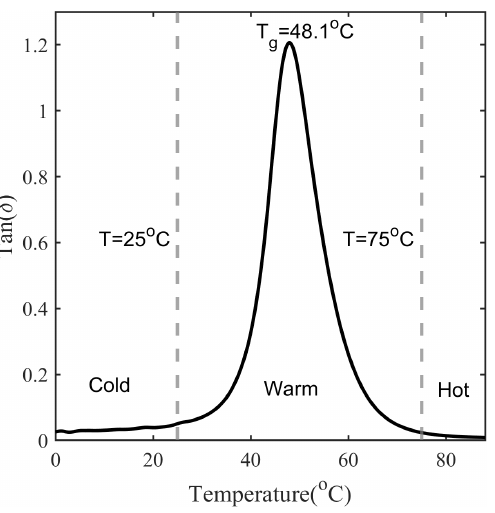
Figure 7. Tan δ measured with DMA at a frequency of 1 Hz and a heating rate of 4